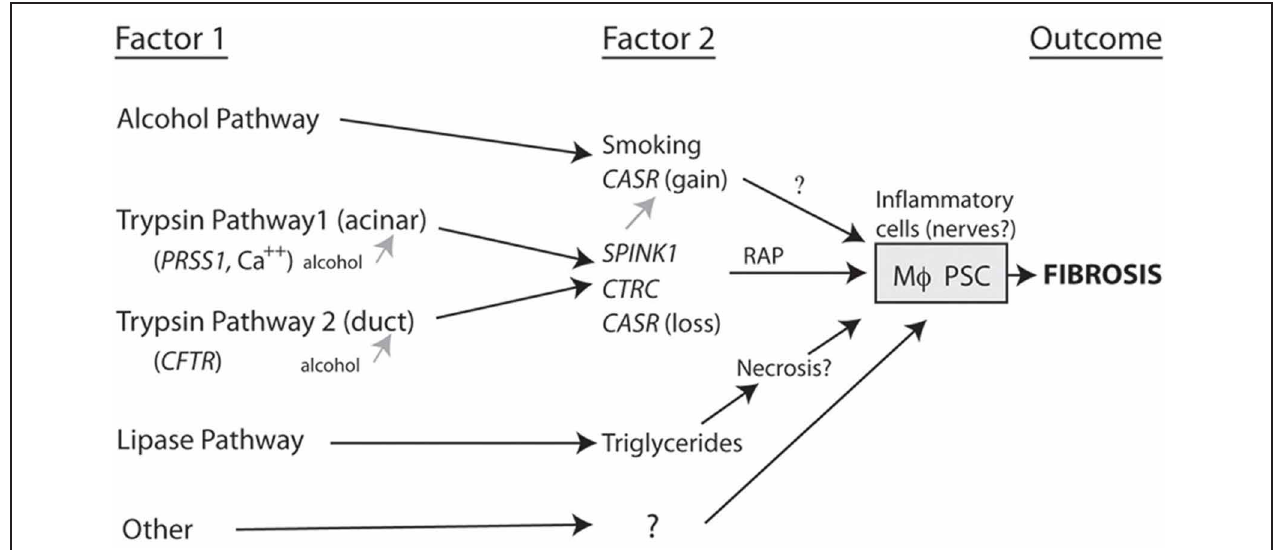
stellate cells, PSC). Note that alcohol can increase susceptibility to pancreatitis by acting on the acinar cell and/or duct cell, but appears to drive CP through another SPINK1 -independent pathway (Aoun et al.,